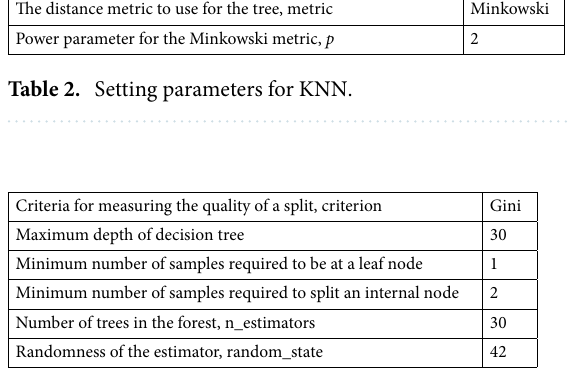
Table 3. Decision tree parameters of the proposed system.